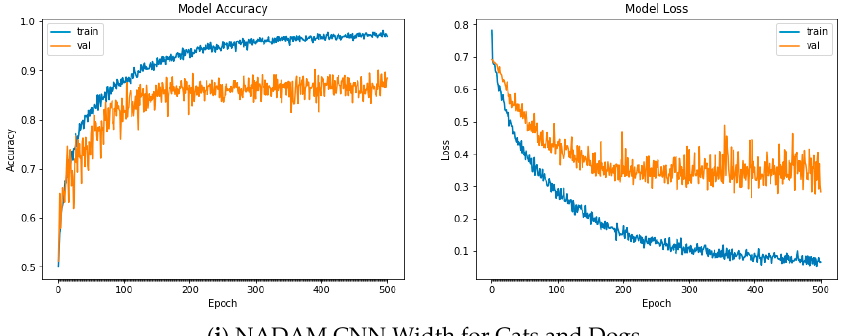
Figure A4. Plots of Train and Validation Test accuracies and losses of the CNN model with varying width for Cats and Dogs: ( a ) Vanilla SGD; ( b ) SGD momentum; ( c ) SGD Nesterov momentum; ( d ) ADAGrad; ( e ) RSMProp; ( f ) ADAM; ( g ) ADADelta; ( h ) ADAMax; ( i ) NADAM.